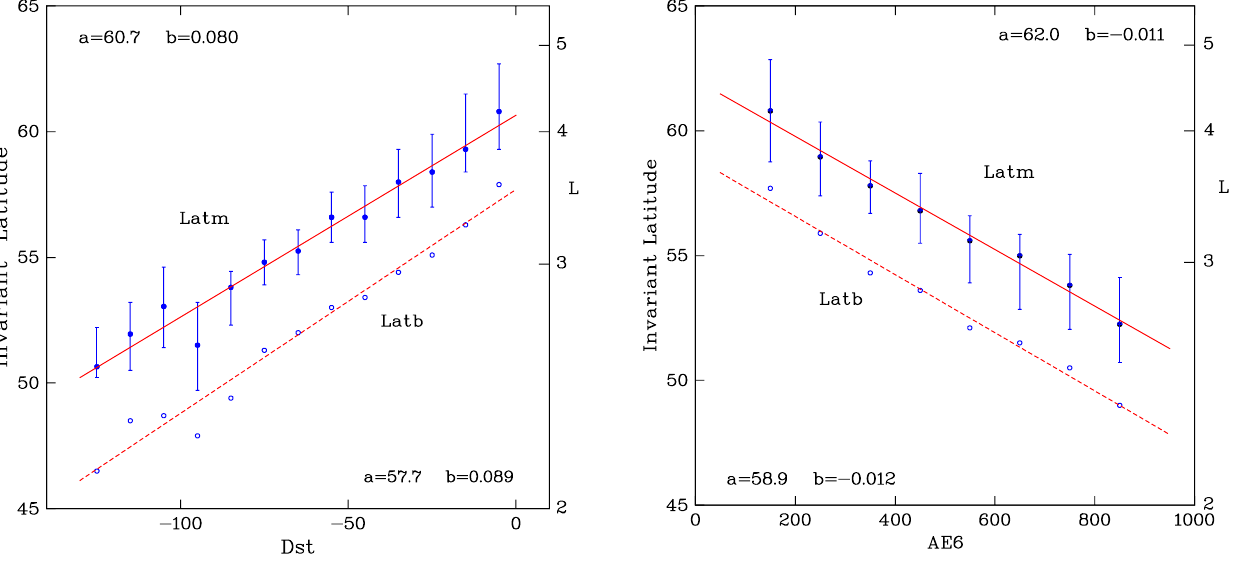
Fig. 5. Position of the subauroral electron temperature enhancement as a function of geomagnetic activity. The format of data presenta- tion corresponds to that of Fig. 4 except that this time the geomag- netic activity is indicated by the AE 6 index. For a definition of this index see Eq. (1). The absolute magnitudes of the correlation coefficients are greater than